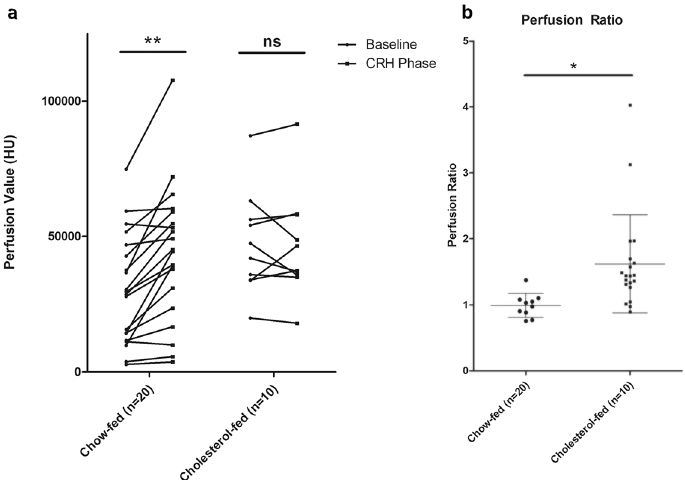
Figure 4. Change of foot perfusion. ( a ) Perfusion value increased in the chow-fed rabbits on CRH phase (35,040.61 ± 17,750.58 to 57,582.43 ± 22,585.11 HU; p = 0.008) while no such surge was demonstrated in the cholesterol-fed group (47,427.59 ± 18,968.08 to 46,692.38 ± 19,797.93 HU; p = 0.878). ( b ) Perfusion ratio, the ratio of perfusion value during CRH to perfusion value at baseline, showed significant drop in the cholesterol group compared to control group ( p =